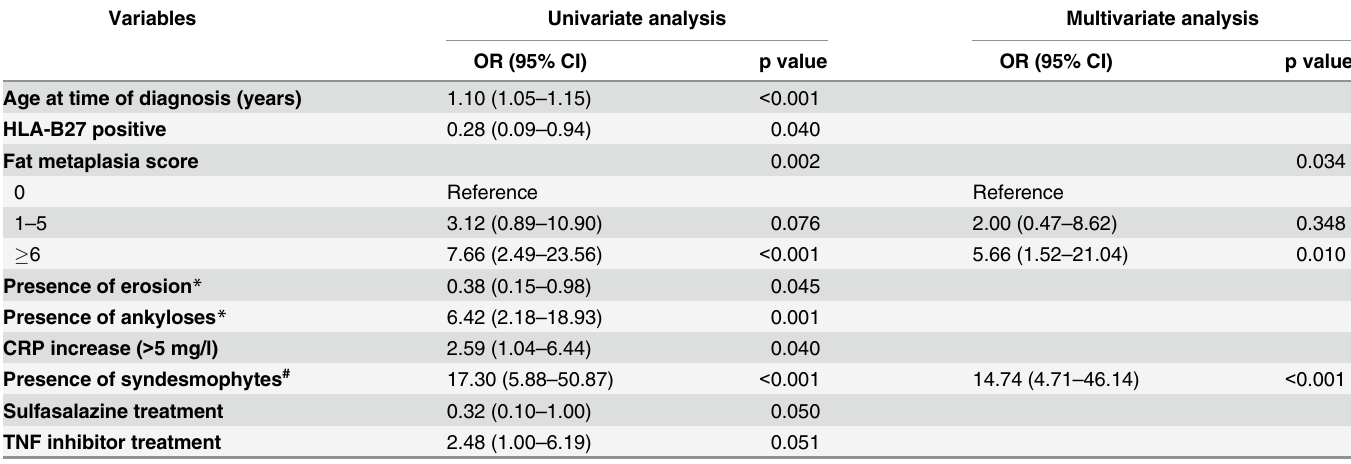
Table 4. Univariate and multivariate analysis of factors associated with radiographic spinal progression over 2 years.